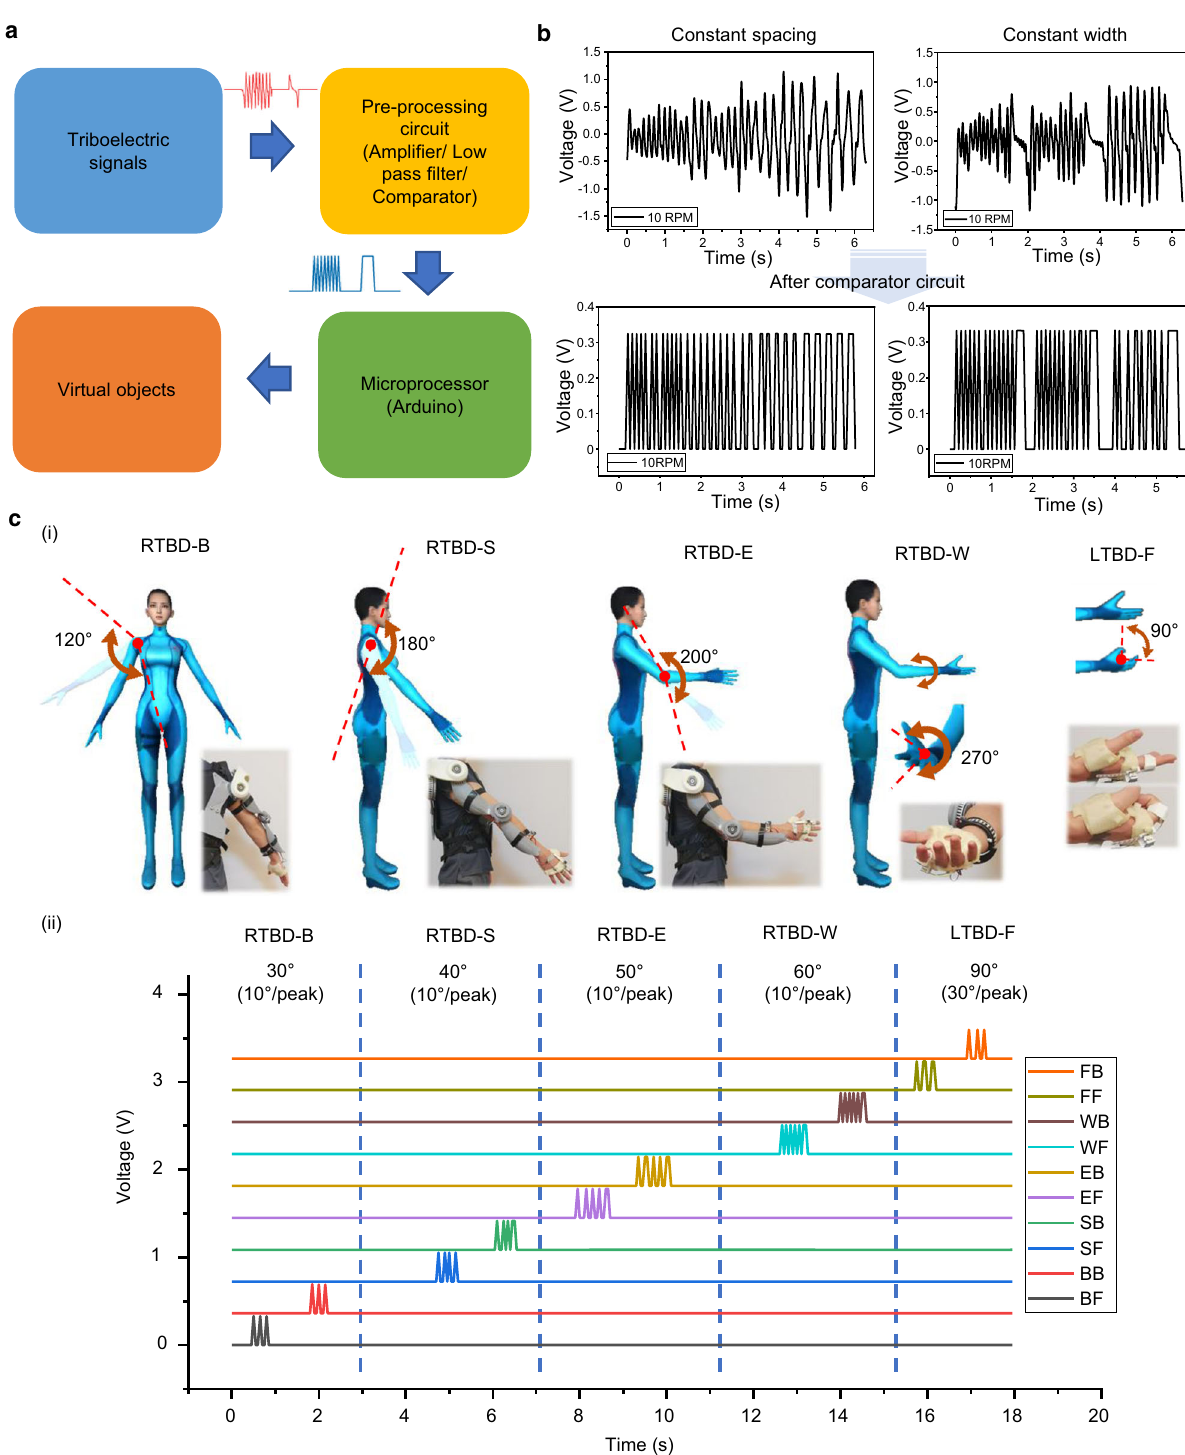
Fig. 3 Signal processing and demonstration in virtual space. a Flow chart of triboelectric signal processing for manipulation in virtual space. b Examples of the original triboelectric signals after the preprocessing circuit. c Demonstration of controlling virtual character: (i) the controllable motions and the activated sensors with the limits of motion ranges for the rotational triboelectric bidirectional back (RTBD-B) sensor, the rotational triboelectric bidirectional shoulder (RTBD-S) sensor, the rotational triboelectric bidirectional elbow (RTBD-E) sensor, the rotational triboelectric bidirectional wrist (RTBD-W) sensor, and the linear triboelectric bidirectional fi nger (LTBD-F) sensor and (ii) the real-time signals during the manipulation, the output channels of BF, BB, SF, SB, EF, EB, WF, WB, FF, and FB stand for the forward (clockwise) and the backward (counterclockwise) rotations of the RTBD-B sensor, the RTBD-S sensor, the RTBD-E sensor, the RTBD-W sensor, and the LTBD-F sensor, i.e., BF for forward rotation of RTBD-B. Photo credit: Minglu Zhu, National University of